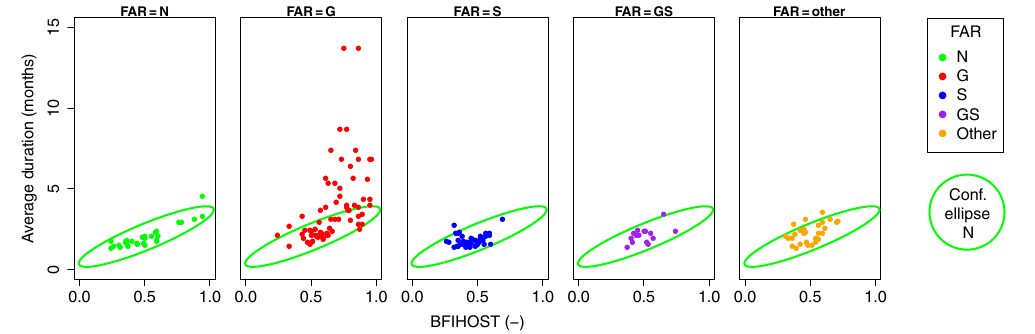
Figure 4. Average streamflow drought duration ( L T,Q ) versus BFIHOST for catchments labelled with different FAR codes (colours). Ellipse reflects the 95% confidence ellipse for catchments with near-natural flow records (FAR = N).